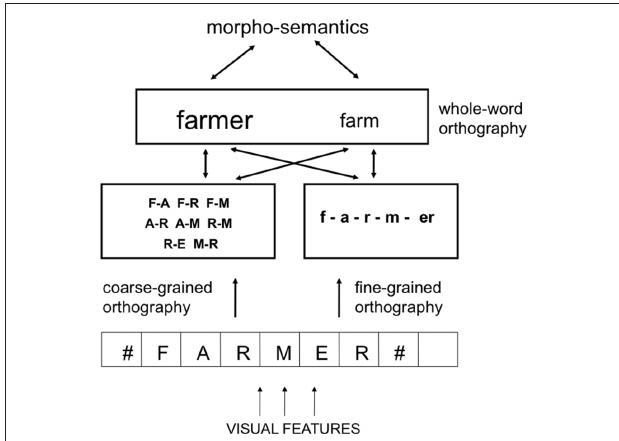
Figure 5 | Morphological processing and the dual-route approach to orthographic processing. Fine-grained orthographic processing enables sublexical morpho-orthographic segmentation via the detection of affixes such as the suffix “er” in the stimulus “farmer.” Activation in these representations is fed-forward to whole-word orthographic representations, increasing the activation level of all compatible units (e.g., “farmer,” “farm”). Coarse-grained orthography activates compatible whole-word orthographic representations. Morpho-semantic representations provide bi-directional connectivity between whole-word representations belonging to the same morphological